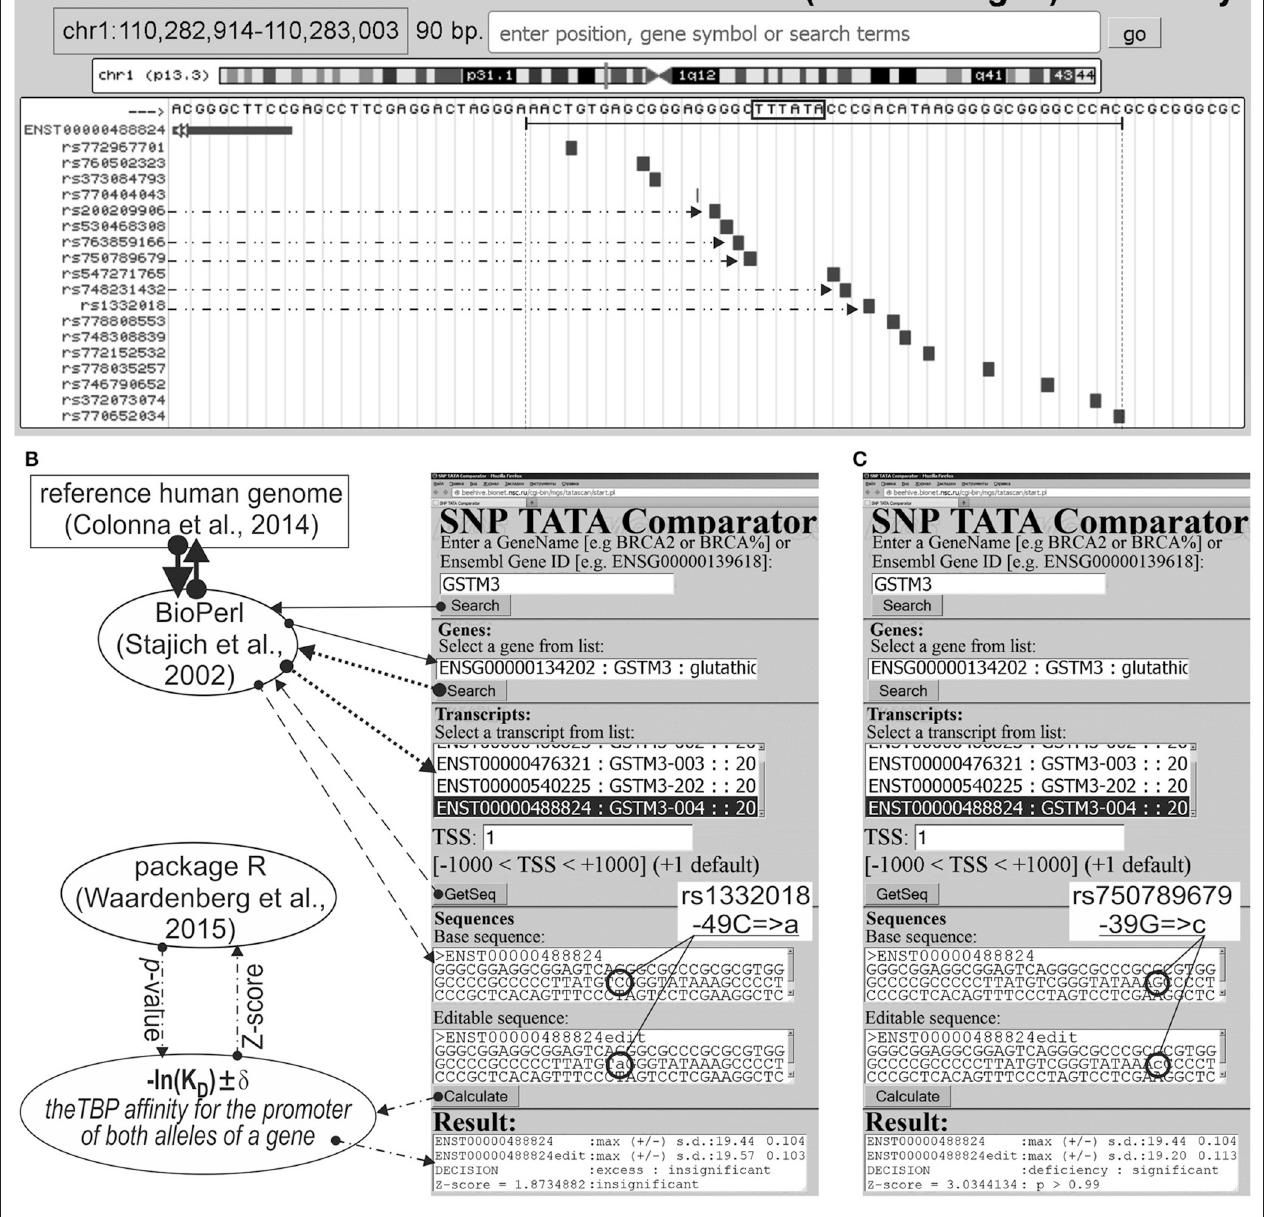
FIGURE 1 | Known and candidate SNP markers of Alzheimer’s disease (AD) near TBP-binding sites of the human GSTM3 gene promoter. (A) Unannotated SNPs (analyzed in this study) in the region [ − 70; − 20] (where all proven TBP-binding sites (boxed) are located; double-headed arrow, ↔ ) of the human GSTM3 gene promoter taken from dbSNP (Sherry et al., 2001) using the UCSC Genome Browser (Haeussler et al., 2015). Dash-and-double-dot arrows: known and candidate SNP markers of sporadic AD are predicted by a significant change in the affinity of TBP for the human GSTM3 gene promoter. (B,C) The results from our Web service (Ponomarenko et al., 2015) for the two SNP markers of sporadic AD: known rs1332018 (Hong et al., 2009; Tan et al., 2013) and candidate marker rs750789679 near the known TBP-binding site (boxed) of the human GSTM3 gene promoter. Solid, dotted, and dashed arrows indicate queries for the gene list, list of transcripts of a certain gene, and DNA sequence of the promoter corresponding to the specified transcript by means of the BioPerl library (Stajich et al., 2002) of the reference human genome (Colonna et al., 2014), respectively. Dash-and-dot arrows: estimates of significance of the alteration of gene product abundance in patients with the minor allele (mut) relative to the norm (ancestral allele, wt) expressed as a Z-score using package R (Waardenberg et al., 2015). Circles indicate the ancestral (wt) and minor (mut) alleles of the SNP marker labeled by its dbSNP ID (Sherry et al., 2001).